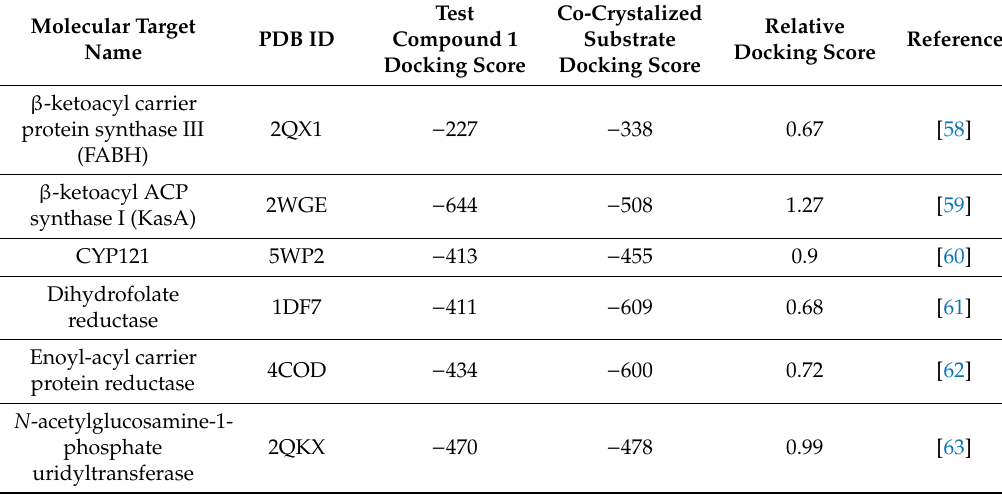
Table 3. The molecular targets used in the computational study to identify the potential target for test the compound 1